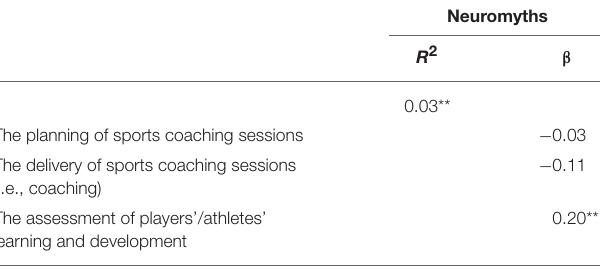
TABLE 5 | Multiple regression predicting neuromyths from attitudes to situations that would be improved by an understanding of the brain.